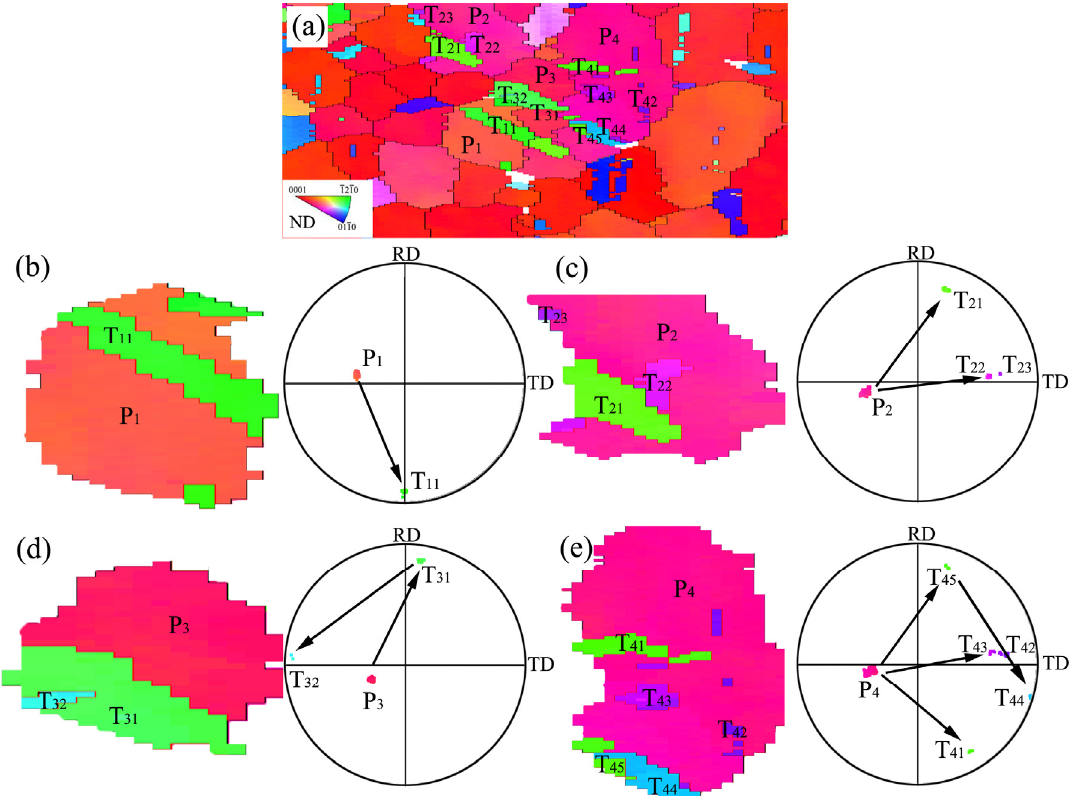
Figure 6. ( a ) WB sample, ( b )–( e ) crystallographic orientation of parent grains and twin lamellae, Here, P i and T ij ( i , j = 1; 2;3) represent the parent grain and twin lamellae, respectively.